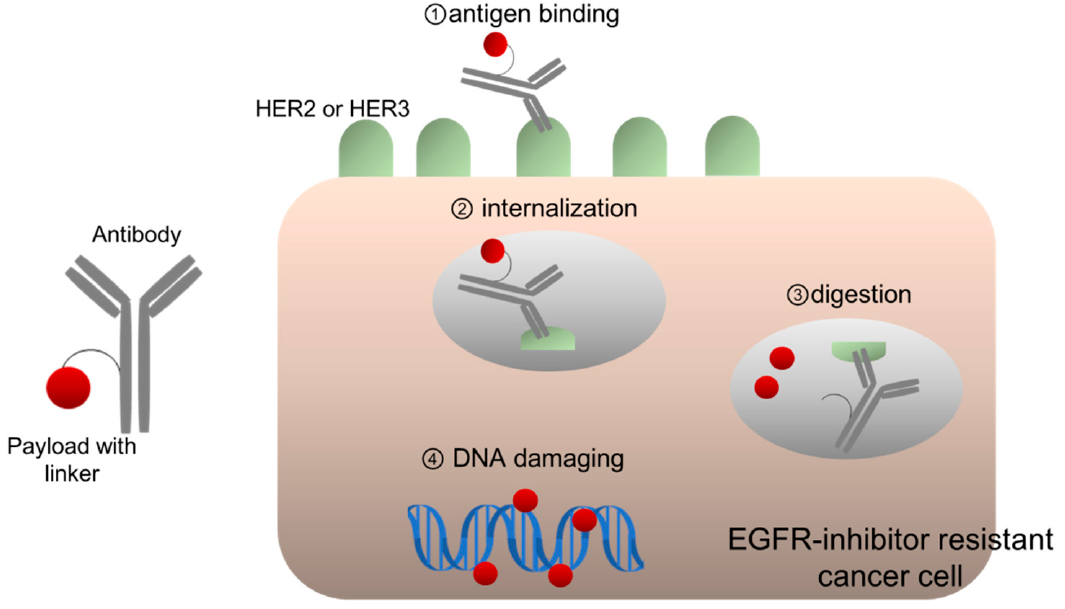
Figure 2. HER2- or HER3-targeting antibody-drug conjugates.